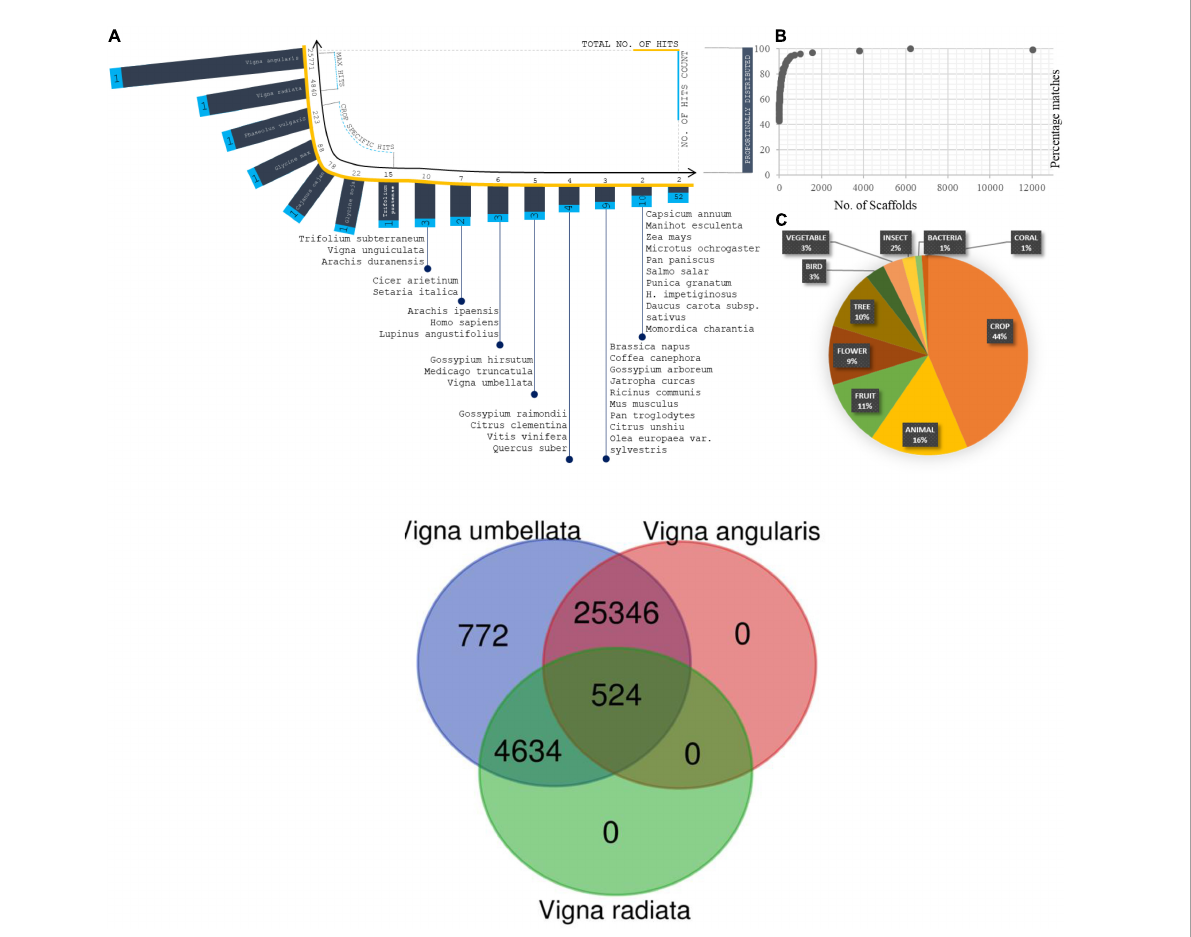
FIGURE5 (A) Distribution of Species from total scaffolds matched from blastX Analysis. Coordinates projected in terms of scaffold matches (total no. of hits and no. of hits counts). (B) Percentage distribution of scaffolds in correspondence of species fall. (C) Plot on total organism matches with